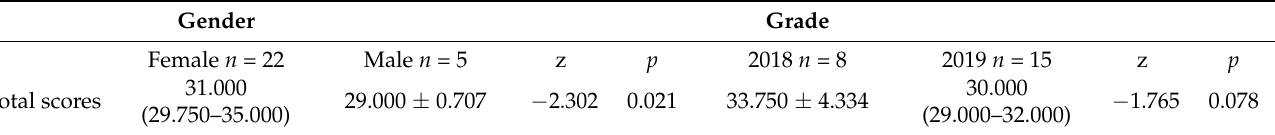
Table 4. Stratification analysis in the increased pressure group (Based on the second questionnaire survey).